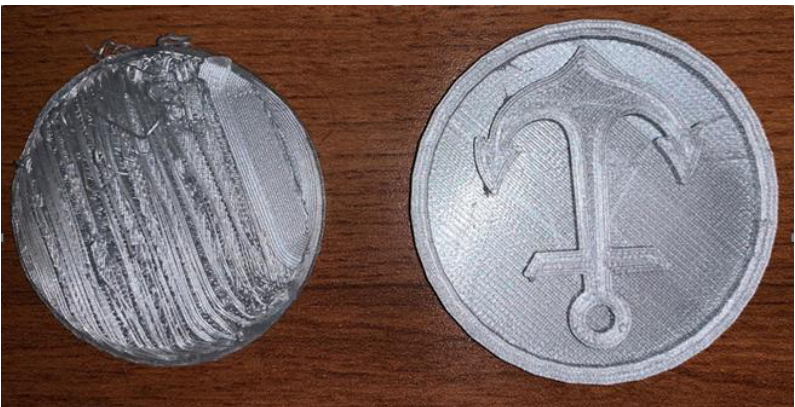
Figure 3. Example of valid and invalid printed parts.